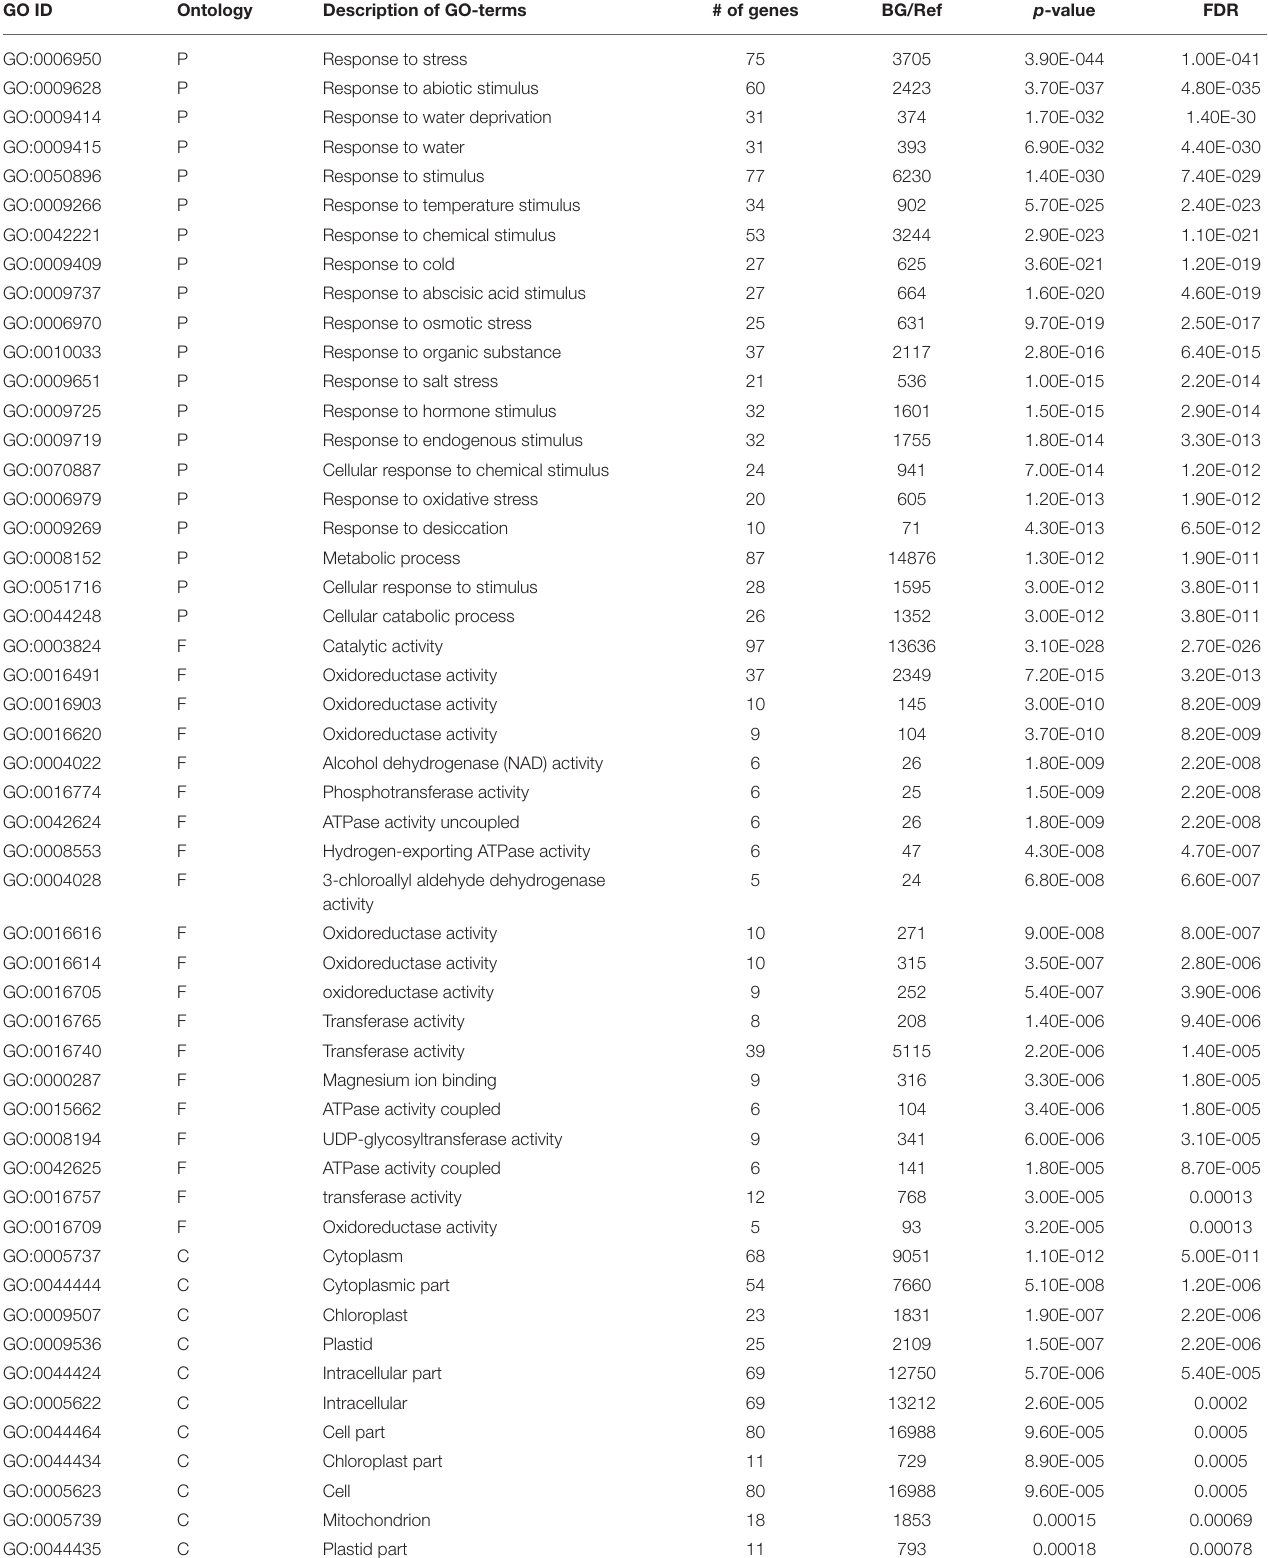
TABLE 1 | Description of GO-terms enriched in drought-associated